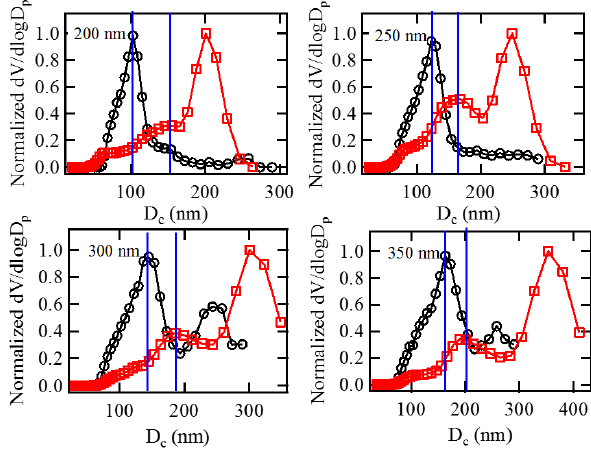
Figure 2. The normalized volume size distribution of the In-BC cores from the SP2 measurements (black marks and line) and the residual particles from the VTDMA measurements at 300 ◦ C (red marks and line). Before the measurements were taken with SP2 at 300 ◦ C, the initial particle sizes selected by DMA1 were 200, 250, 300 and 350nm. The blue lines represent the In-BC core sizes at the peaks of the volume size distribution from the VTDMA and SP2 measurements. The In-BC core size is characterized by the mass- equivalent diameter determined from the SP2 measurement and the mobility diameter from the VTDMA